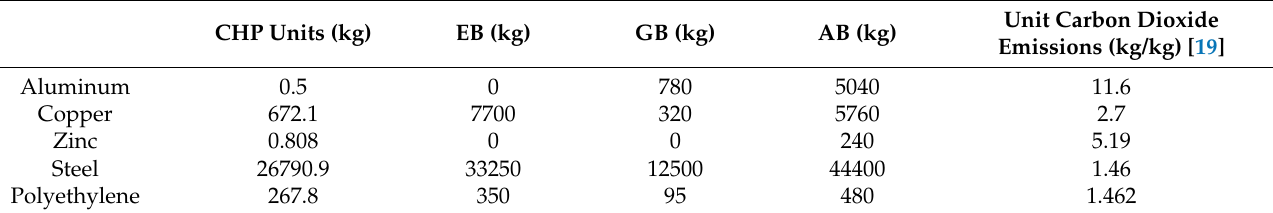
Table 2. Construction materials data of EH devices in the test system.